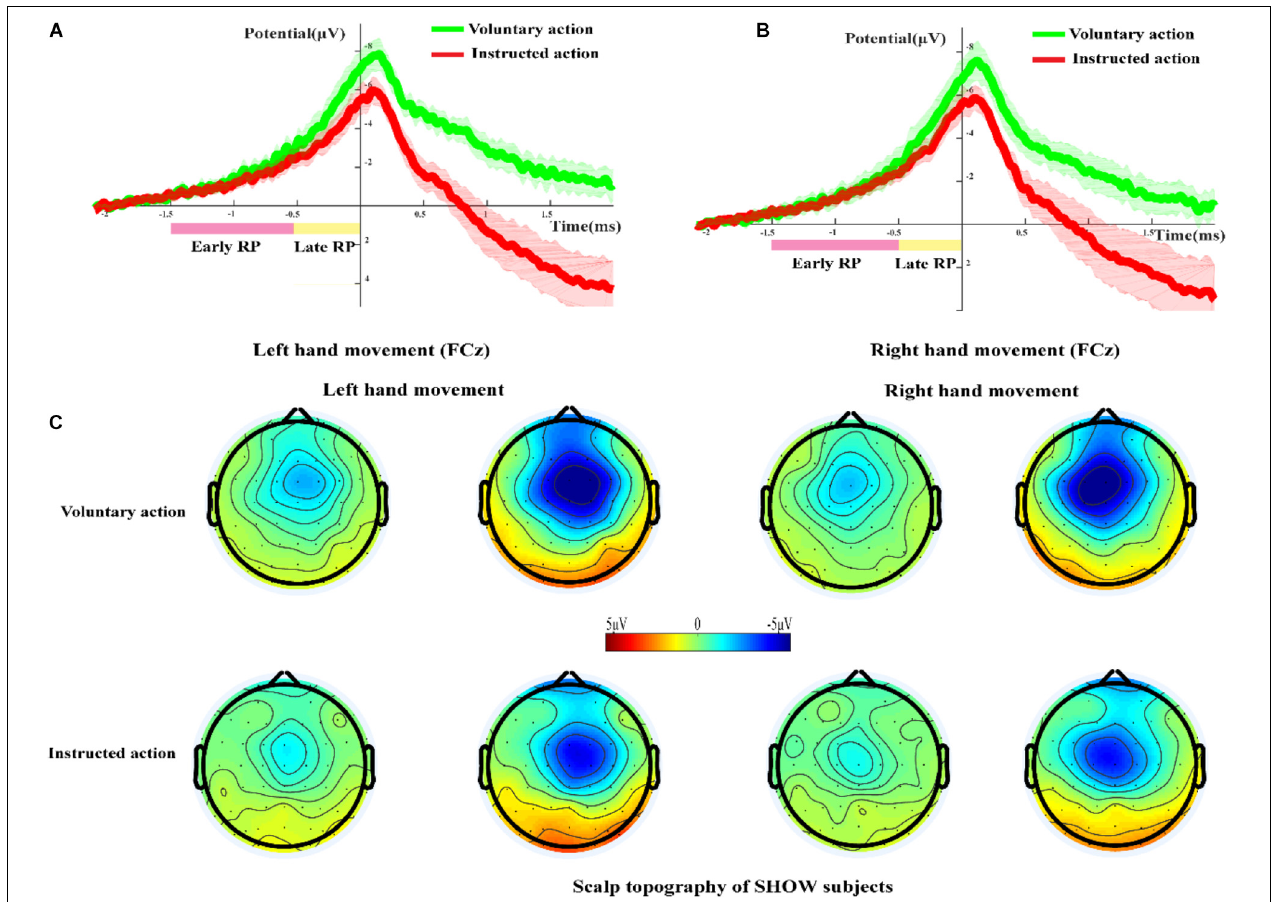
FIGURE 4 | The RP and scalp topography in the SHOW group. (A,B) Grand-averaged RP waveforms during voluntary action and instructed action in the SHOW group at the FCz site ( A , left-hand movement; B , right-hand movement). (C) Scalp topography of the early and late RPs during voluntary action and instructed action in the SHOW